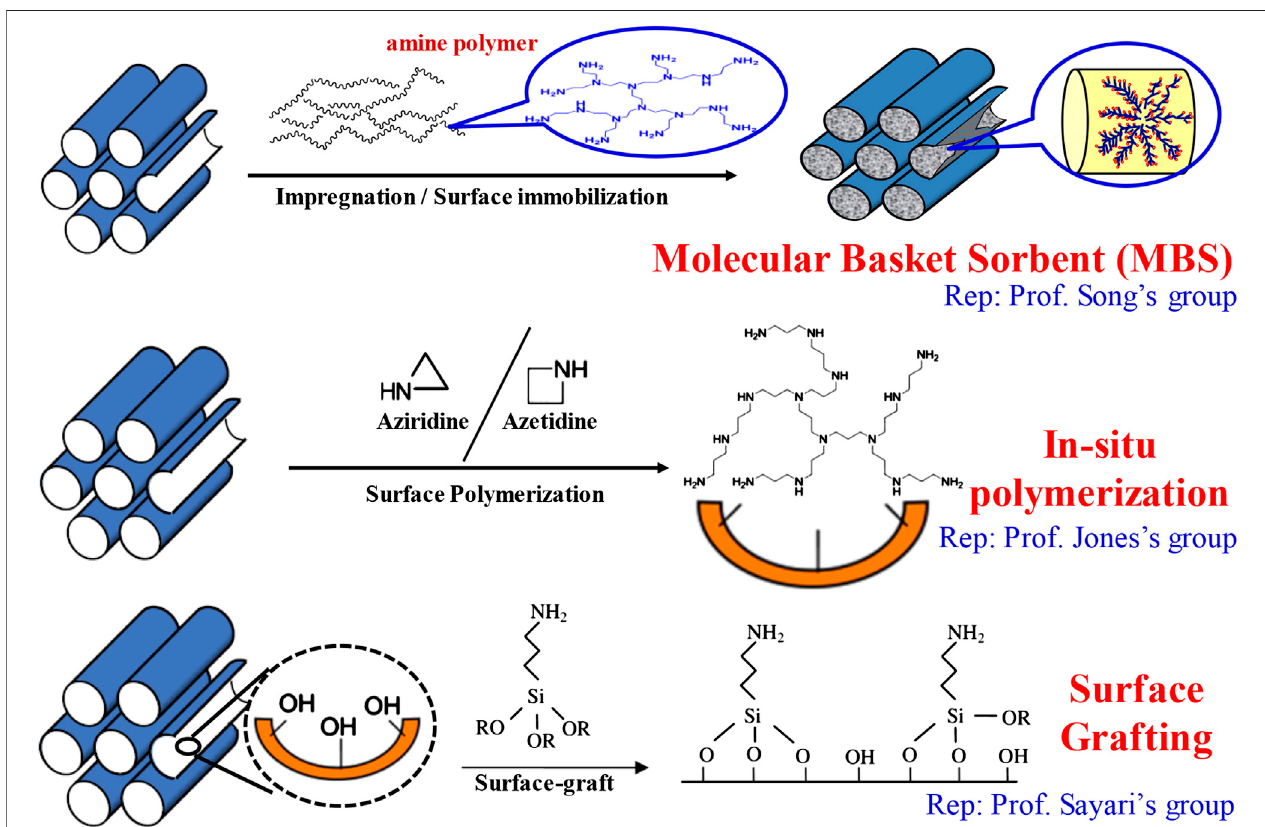
FIGURE 6 | Schematic illustration of the widely used three approaches in preparation of the amine-based sorbents.